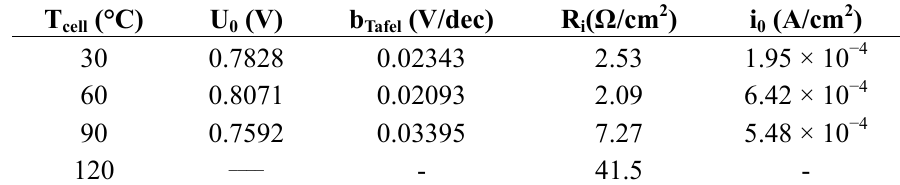
Table 2. Electrode parameters of MEA anode at different temperatures (assuming the anode as MEA reaction rate control